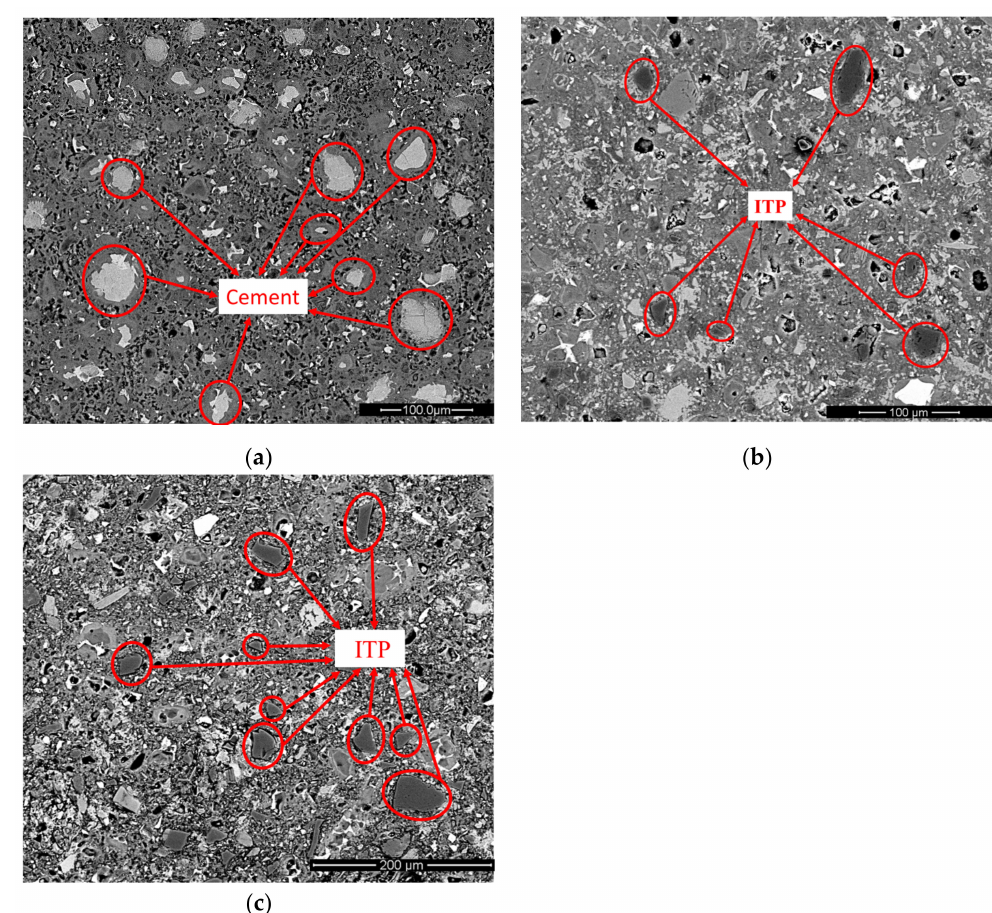
Figure 11. BSE images of cement-ITP hardened pastes cured for 365 days at 60 ◦ C: ( a ) HP0; ( b ) HP20; ( c )